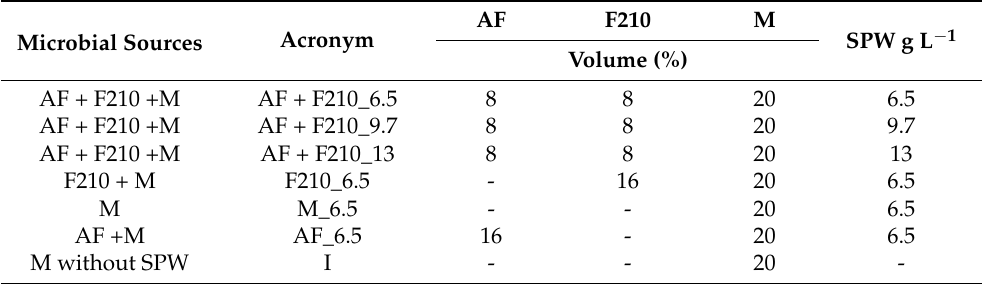
Table 2. Framework of the experimental plan. A base concentration of SPW of 6.5 gVS L − 1 was